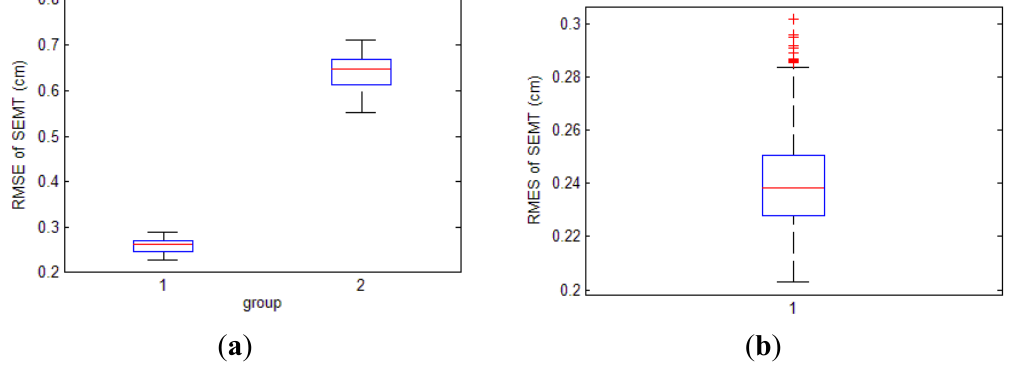
Figure 14. Distribution of SEMT’s errors. ( a ) Errors of the first layout style. Group 1 consists of the twenty-six points of higher accuracy, and group 2 consists of the other twenty two with lower accuracy; ( b ) Errors of the second layout style.